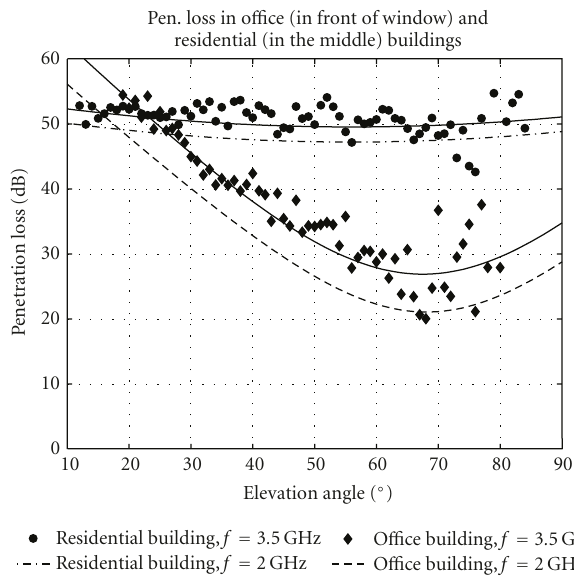
Figure 10: Comparison of penetration loss as a function of the elevation angle for di ff erent environments and carrier frequencies of 2.0 GHz and